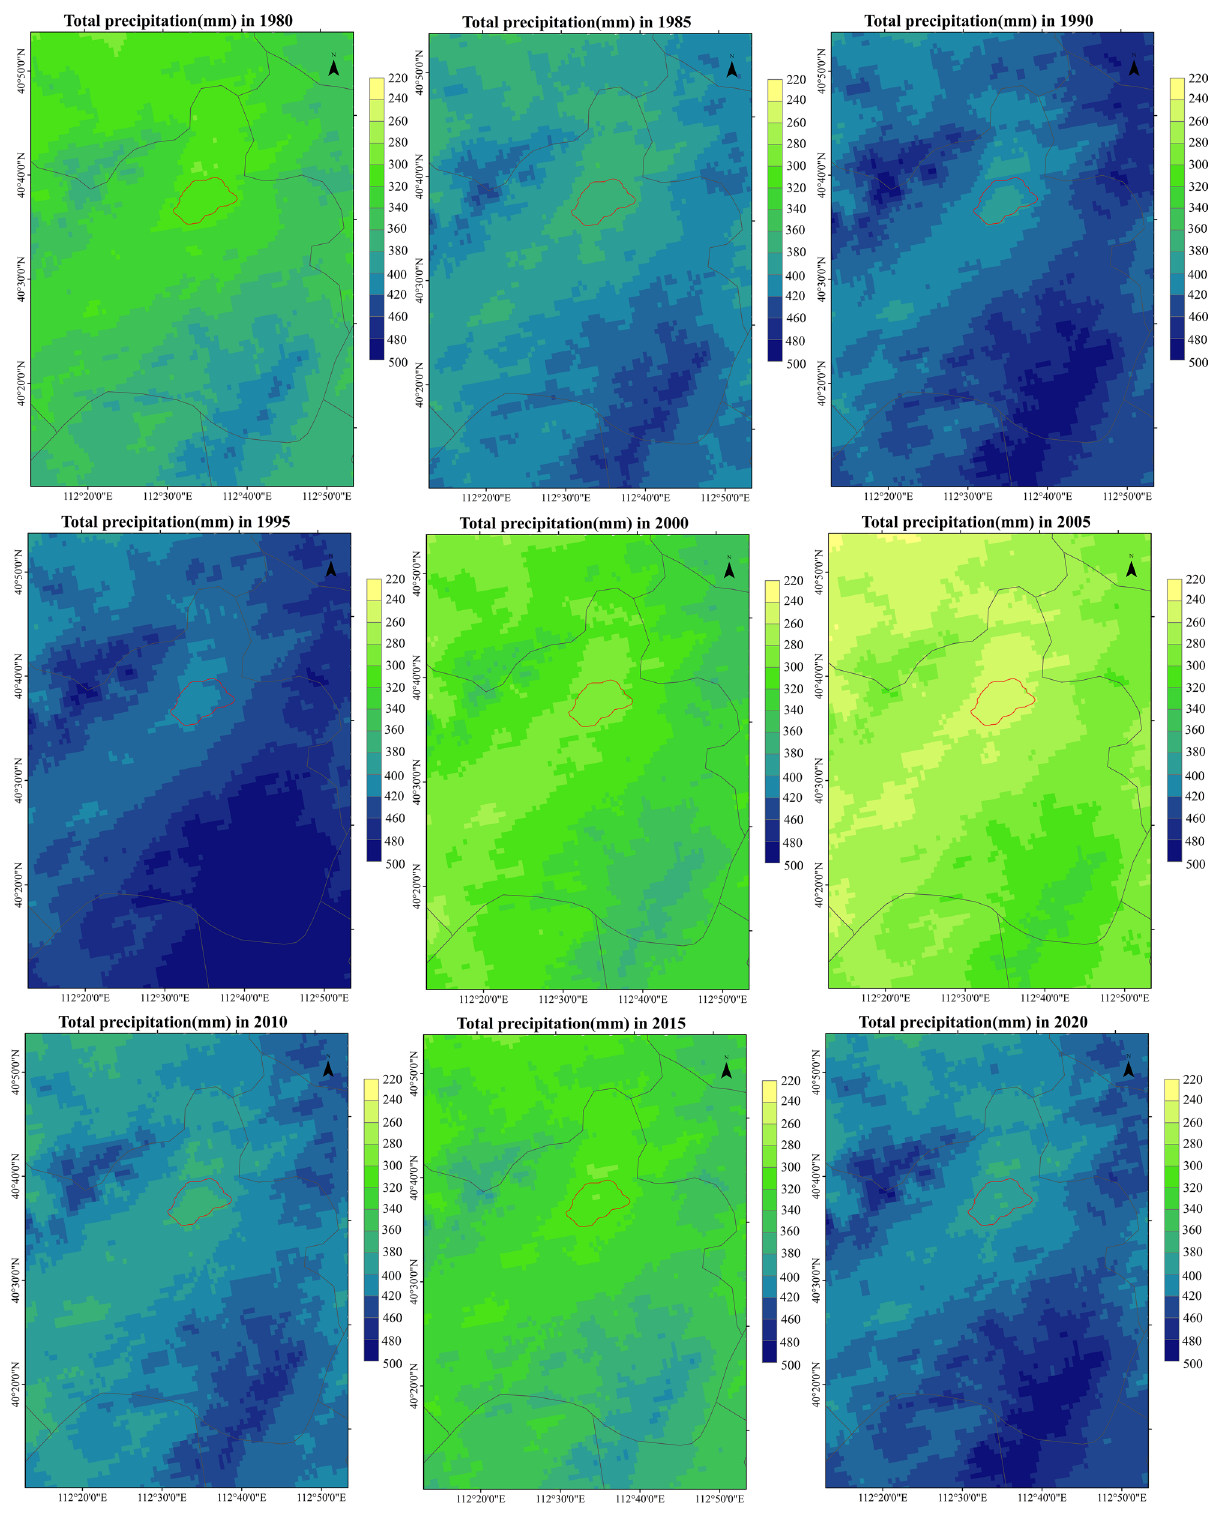
Figure 6. Spatial distribution of annual precipitation in Daihai